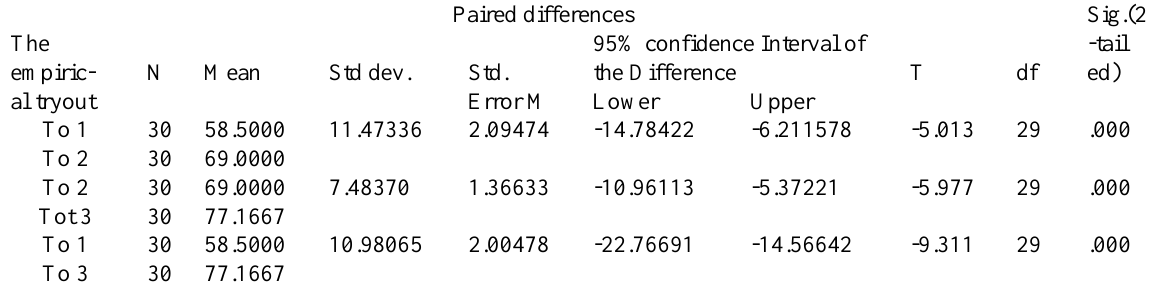
TABLE 4 | The Result of the Second Tryout at ES III